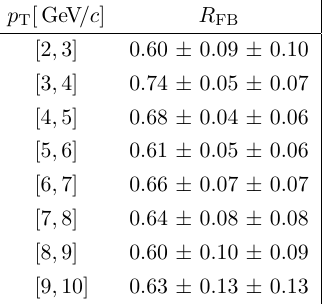
Table 5 . Forward-backward prompt (cid:3) + production ratio R FB as a function of p T in the common c range 2 : 5 < j y (cid:3) j < 4 : 0. The (cid:12)rst uncertainty is statistical and the second is systematic.